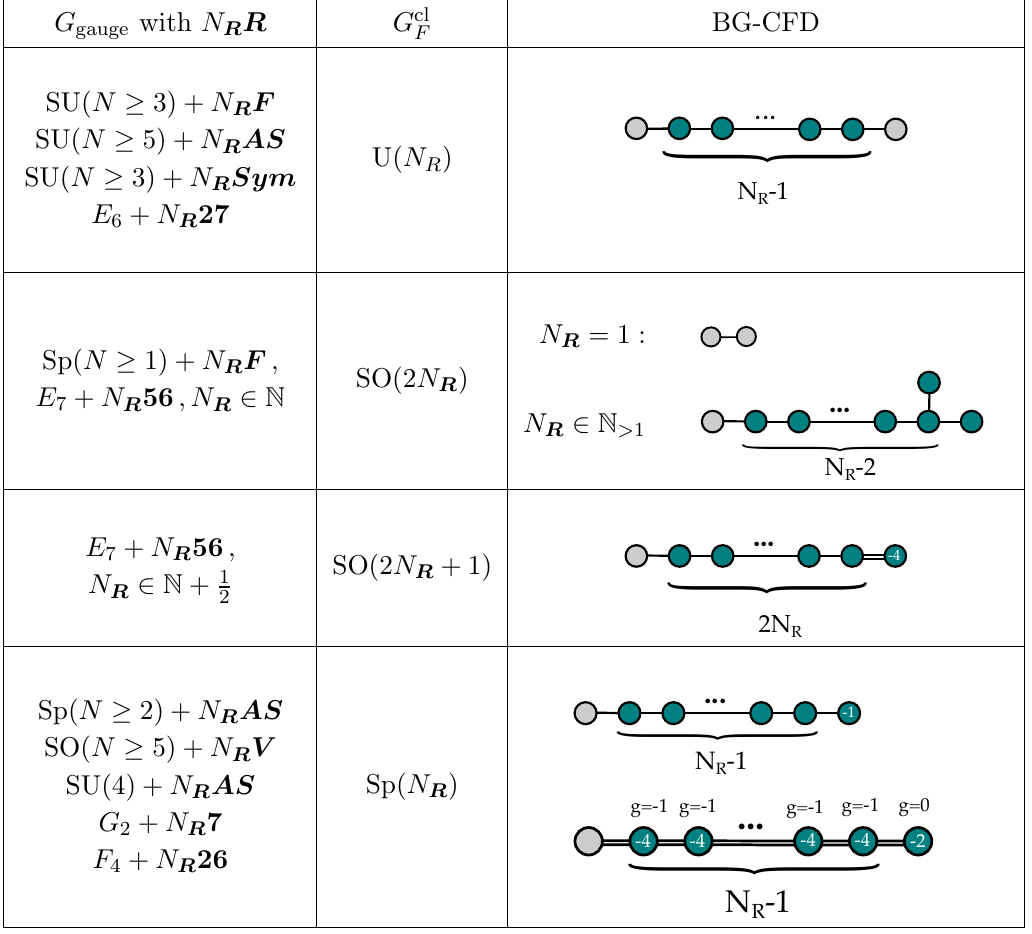
Table 1. The list of BG-CFDs with the gauge theory descriptions and classical (cid:13)avor symmetry G F . The grey vertices denote ( n; g ) = ( (cid:0) 1 ; 0) vertices in the CFD that can be removed via cl a CFD transition. In the Sp( N R ) case, the two BG-CFDs are equivalent in the sense that the intersection matrices are rescaled by a factor of two. Note that the grey node in the BG-CFD with ( n; g ) = ( (cid:0) 4 ; (cid:0) 1) vertices should be a type (V4) vertex with ( n; g ) = ( (cid:0) 2 ; (cid:0)